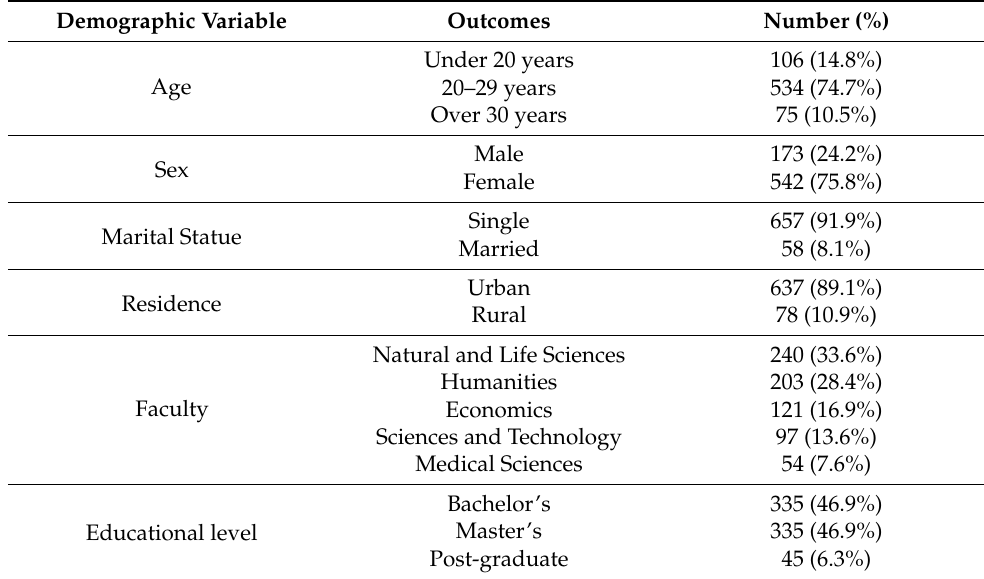
Table 1. The demographics of the study